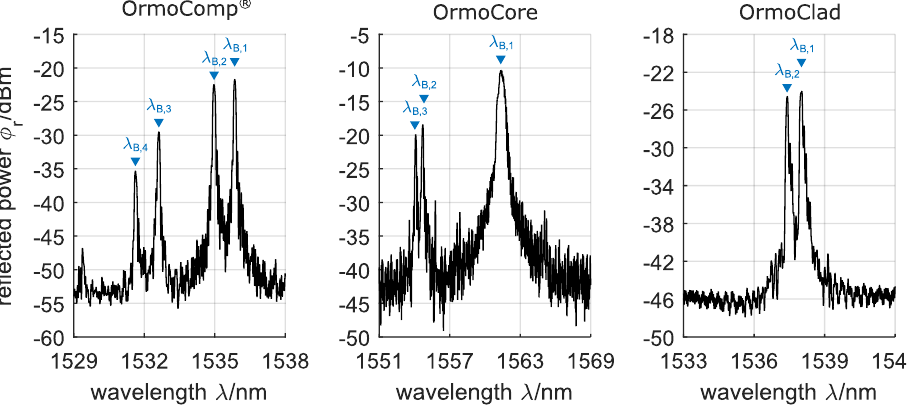
Figure 3. Reflection spectra of embedded channel waveguide Bragg gratings in OrmoComp ® , OrmoCore, and OrmoClad, fabricated with a single writing step